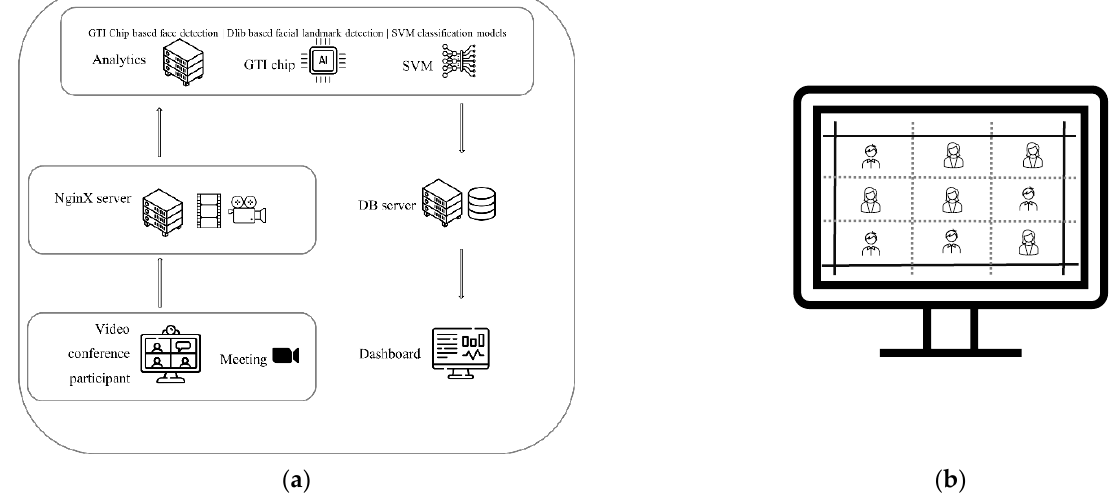
Figure 2. Architecture A: ( a ) system architecture; ( b ) video slicing interface.